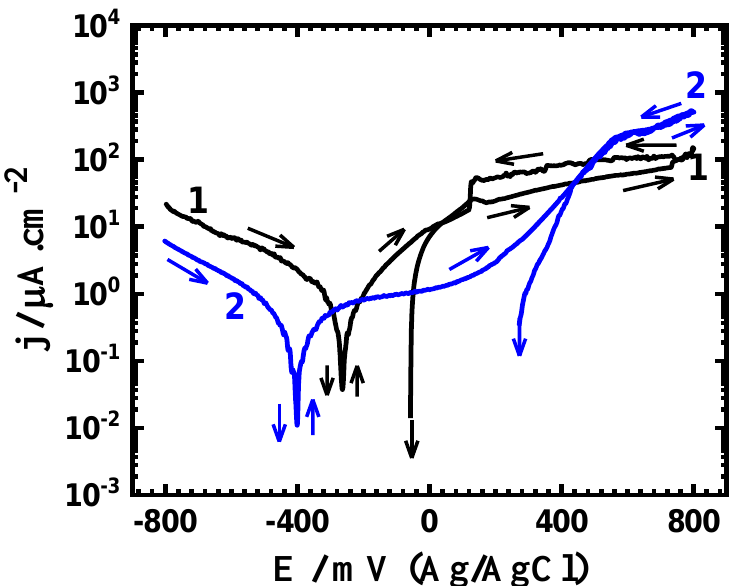
Figure 4. The polarization curves obtained for (1) Ti-6%Al and (2) Ti-6%Al-4%V alloys after their immersions in the chloride solution for 48 h. Table 1. Polarization data for the Ti alloys after immersion in 3.5% NaCl solution for various periods of time.